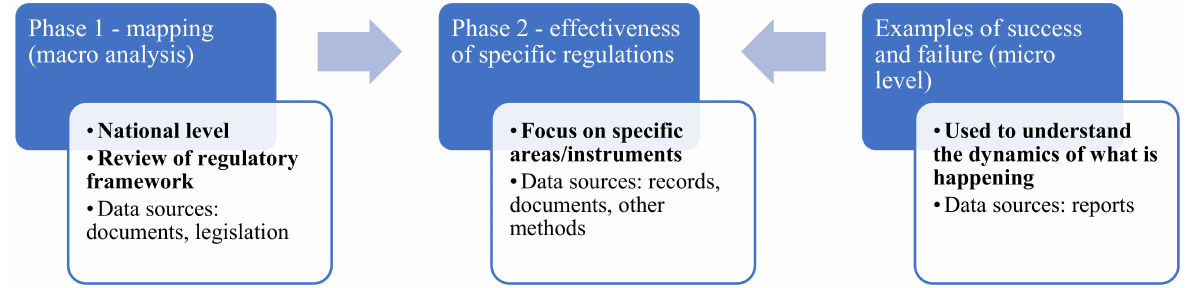
Figure 1. Conceptual framework adopted